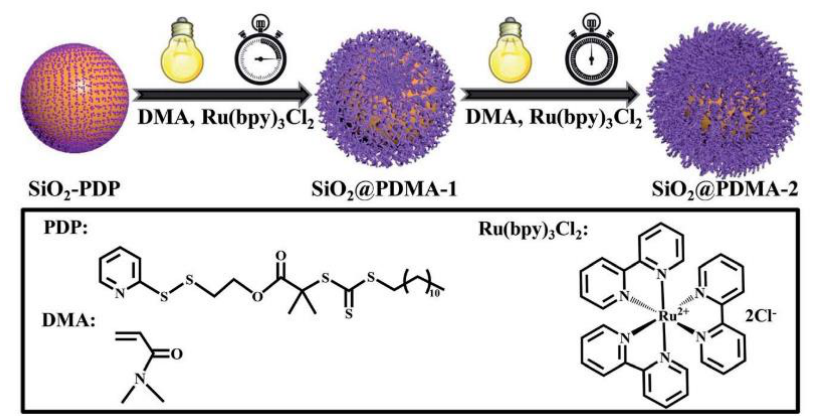
Figure 10. Synthesis of silica-polymer nanocomposites exploiting PET-RAFT approach. Reproduced with permission from ref. [79]. with permission from ref.